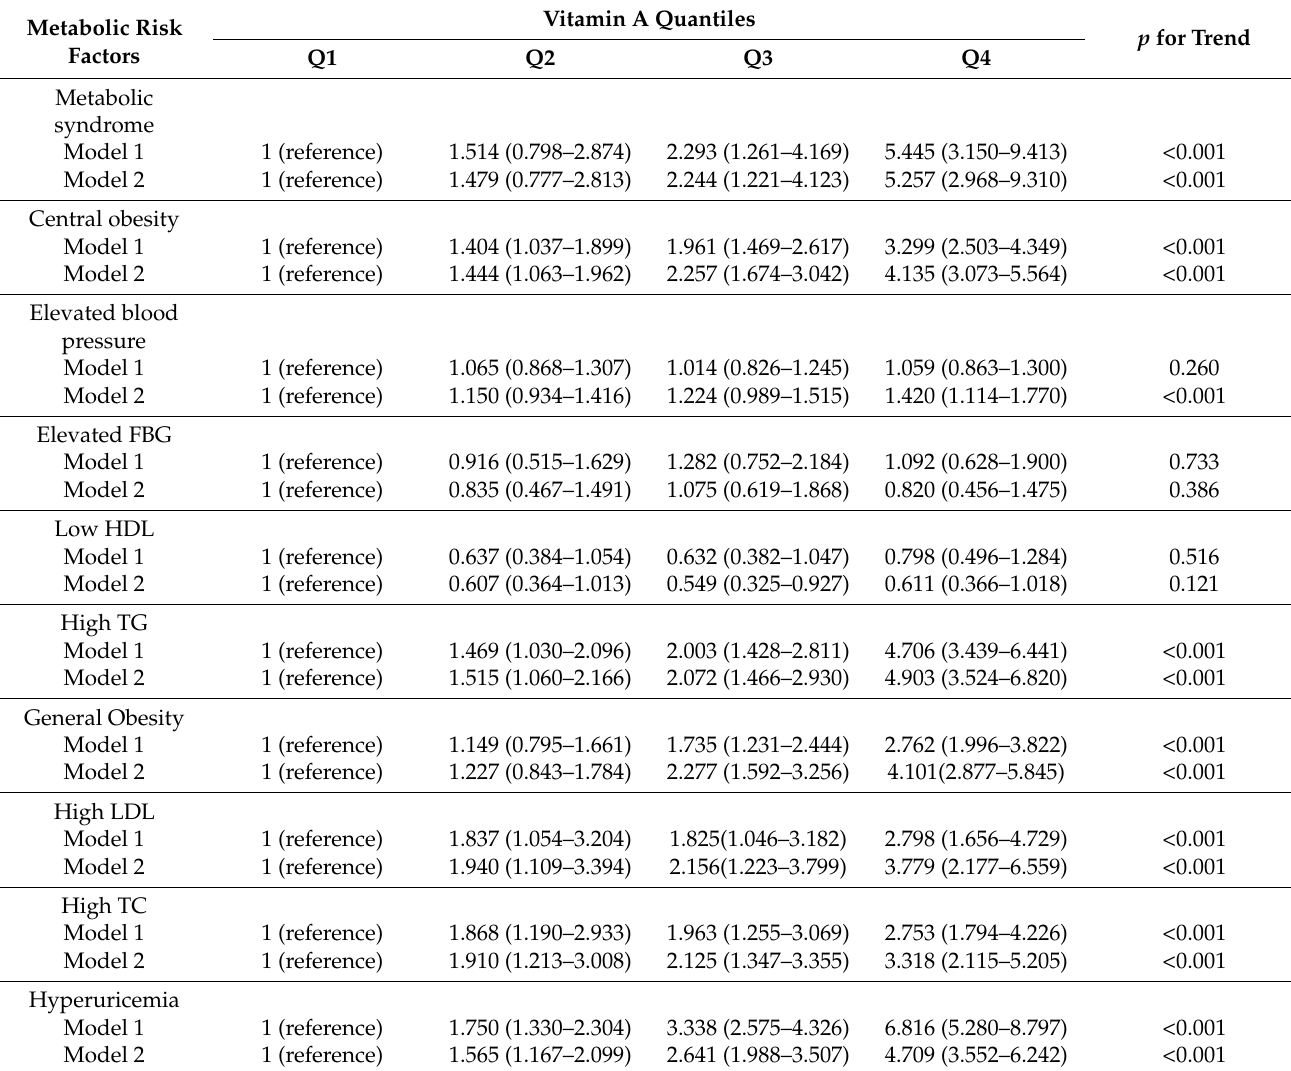
Table 3. Association of metabolic risk factors and serum vitamin A in logistic regression analysis in 7–17 years males and females.